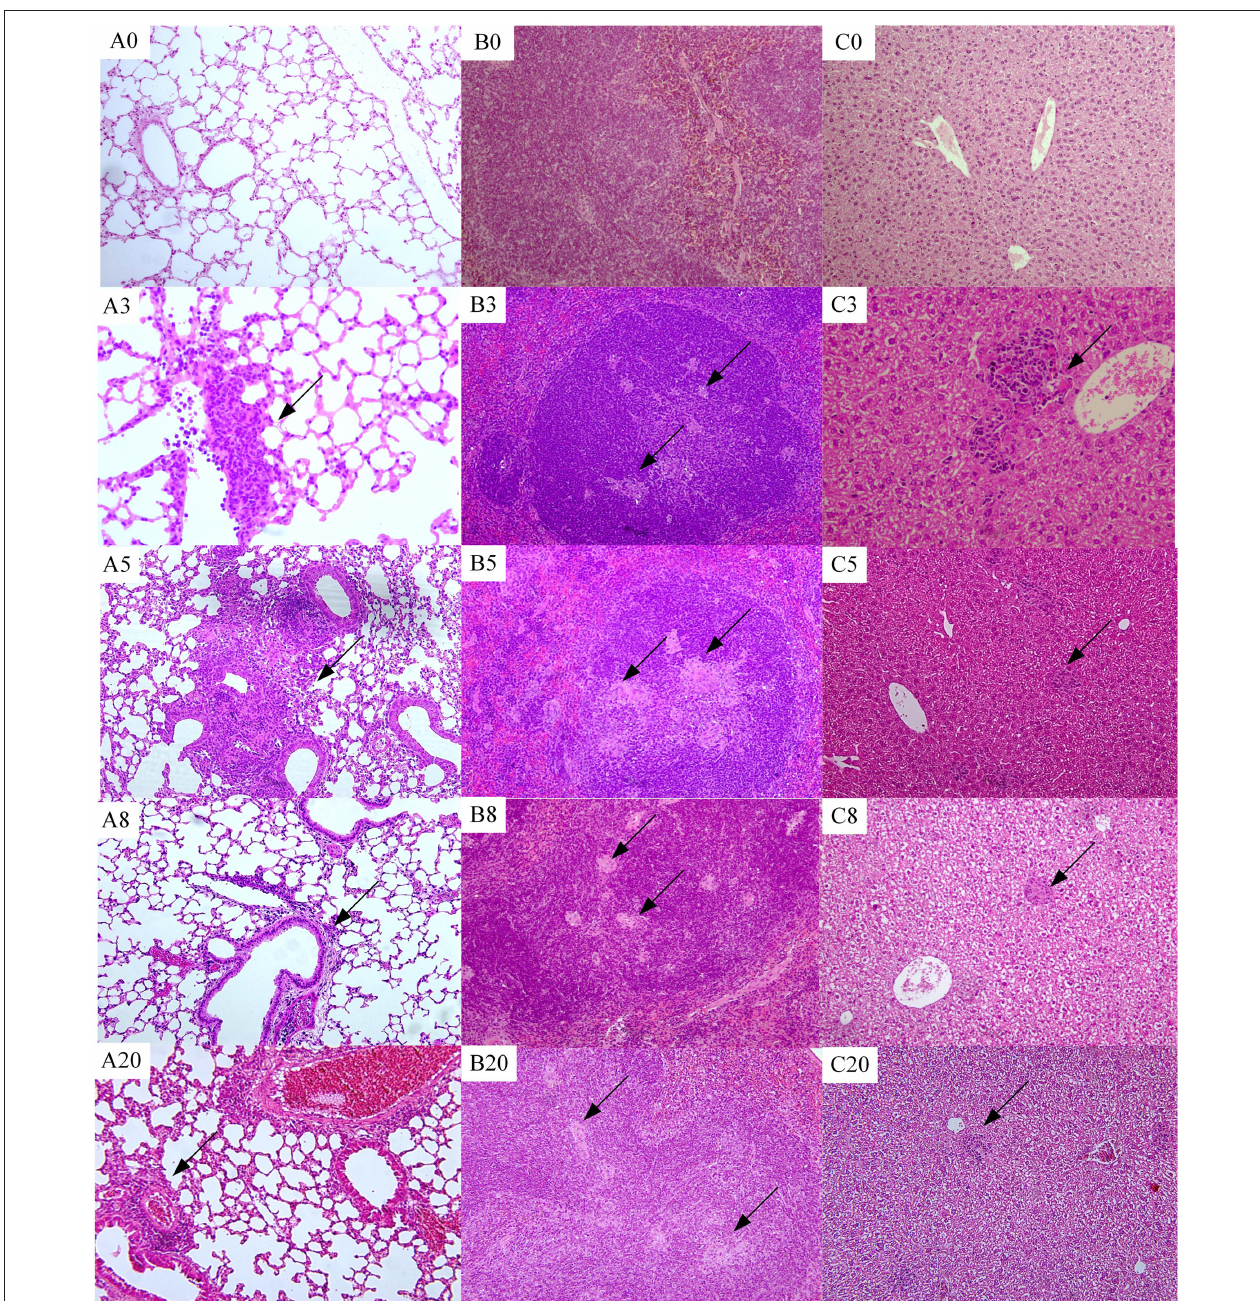
FIGURE 2 | Histopathological changes over time (100 × ). (A0–A20) Lung histology at weeks 0, 3, 5, 8, and 20, respectively. (B0–B20) Spleen histopathology at weeks 0, 3, 5, 8, and 20. (C0–C20) Liver histopathology at weeks 0, 3, 5, 8, and 20. Arrow indicates granulomas-like lesion.